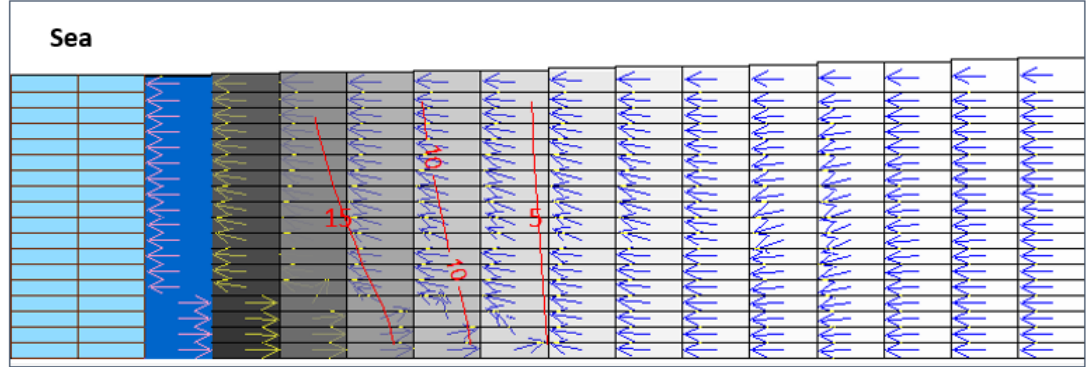
Figure 11. Simulated state of equilibrium of the seawater intrusion in the area of Ambabbo. NS vertical cross-section. Concentration in kg/m 3 .